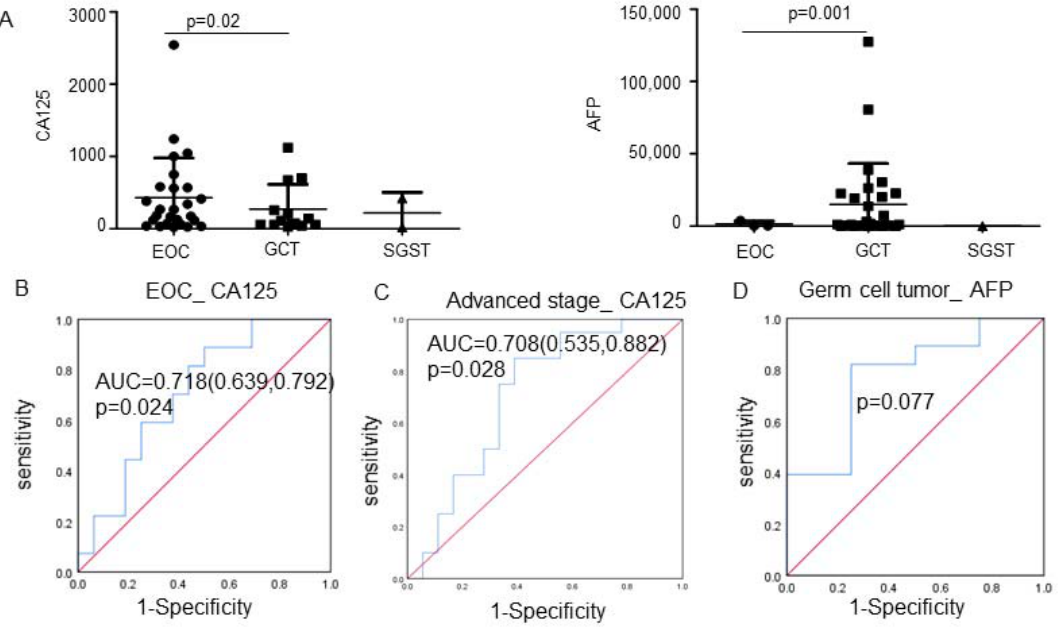
Figure 2. ( A ) The serum CA ‐ 125 and AFP levels in the EOC group, GCT group, SGST group and healthy control group. ( B ) Receiver operating characteristic curve of serum CA ‐ 125 in the diagnosis of patients with epithelial ovarian cancer. ( C ) Receiver operating characteristic curve of serum CA ‐ 125 to predict advanced ‐ stage ovarian cancer during pregnancy. ( D ) Receiver operating characteristic curve of serum AFP in the diagnosis of patients with germ cell tumors during pregnancy. (bule line: ROC curve; red line: reference line) Abbreviations: EOC, epithelial ovarian cancer; GCTs, germ cell tumors; SCSTs, sex cord ‐ stromal tumors; CA ‐ 125, cancer antigen 125; AFP, alpha ‐ fetoprotein; AUC, area under the curve.